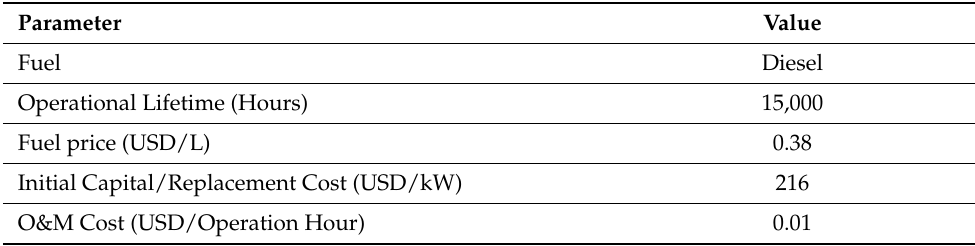
Table 9. Diesel generator